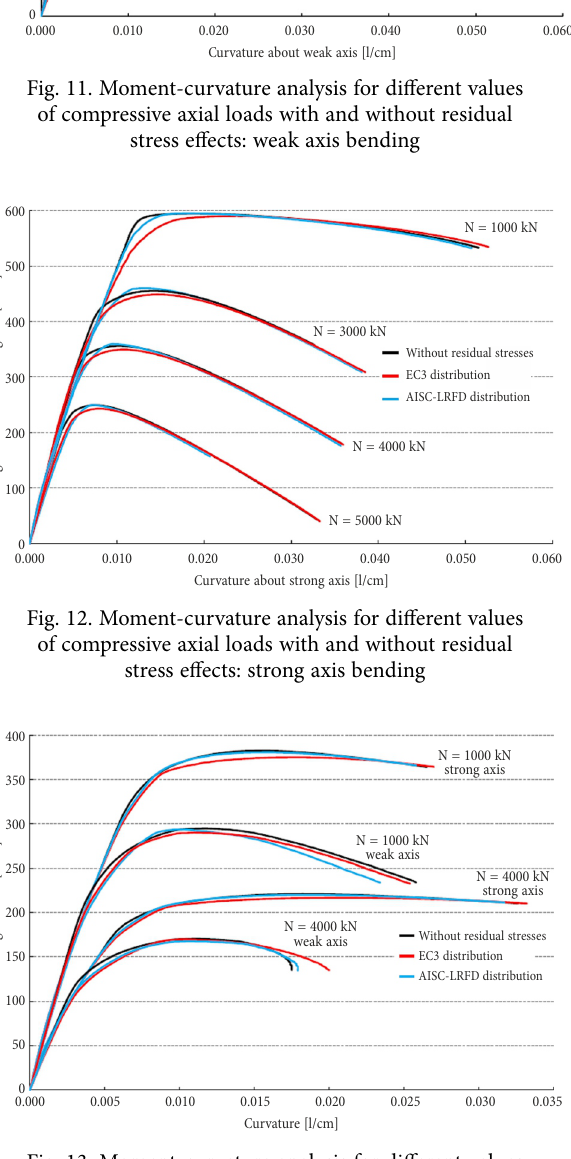
Fig. 13. Moment-curvature analysis for different values of compressive axial loads with and without residual stress effects: Bi-axial bending a = 30 °